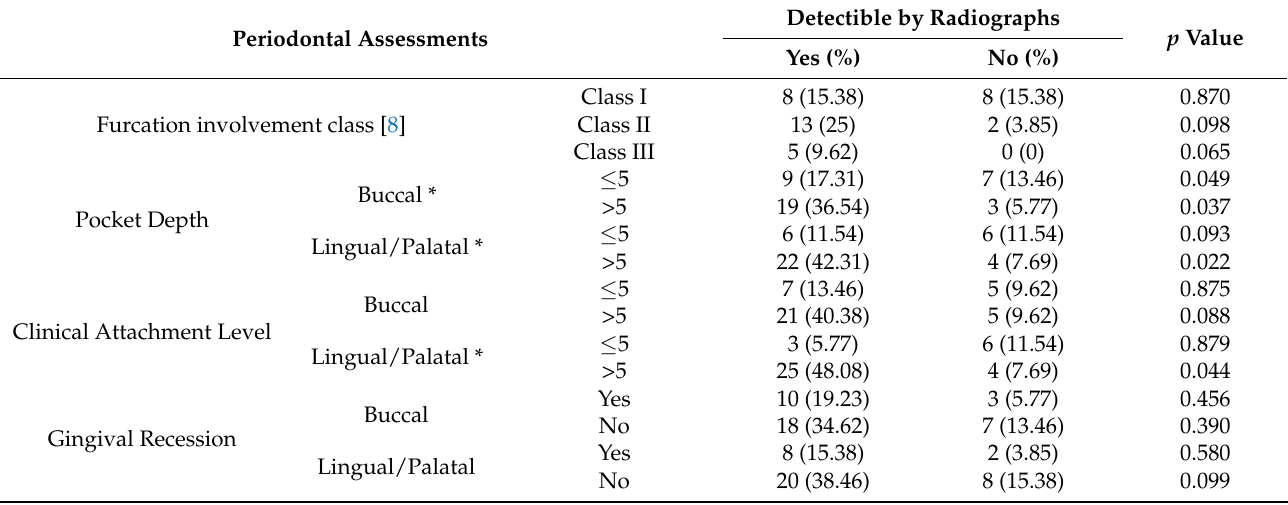
Table 5. Relation between the Class of furcation and other periodontal data to the radiographic detectability of furcation for